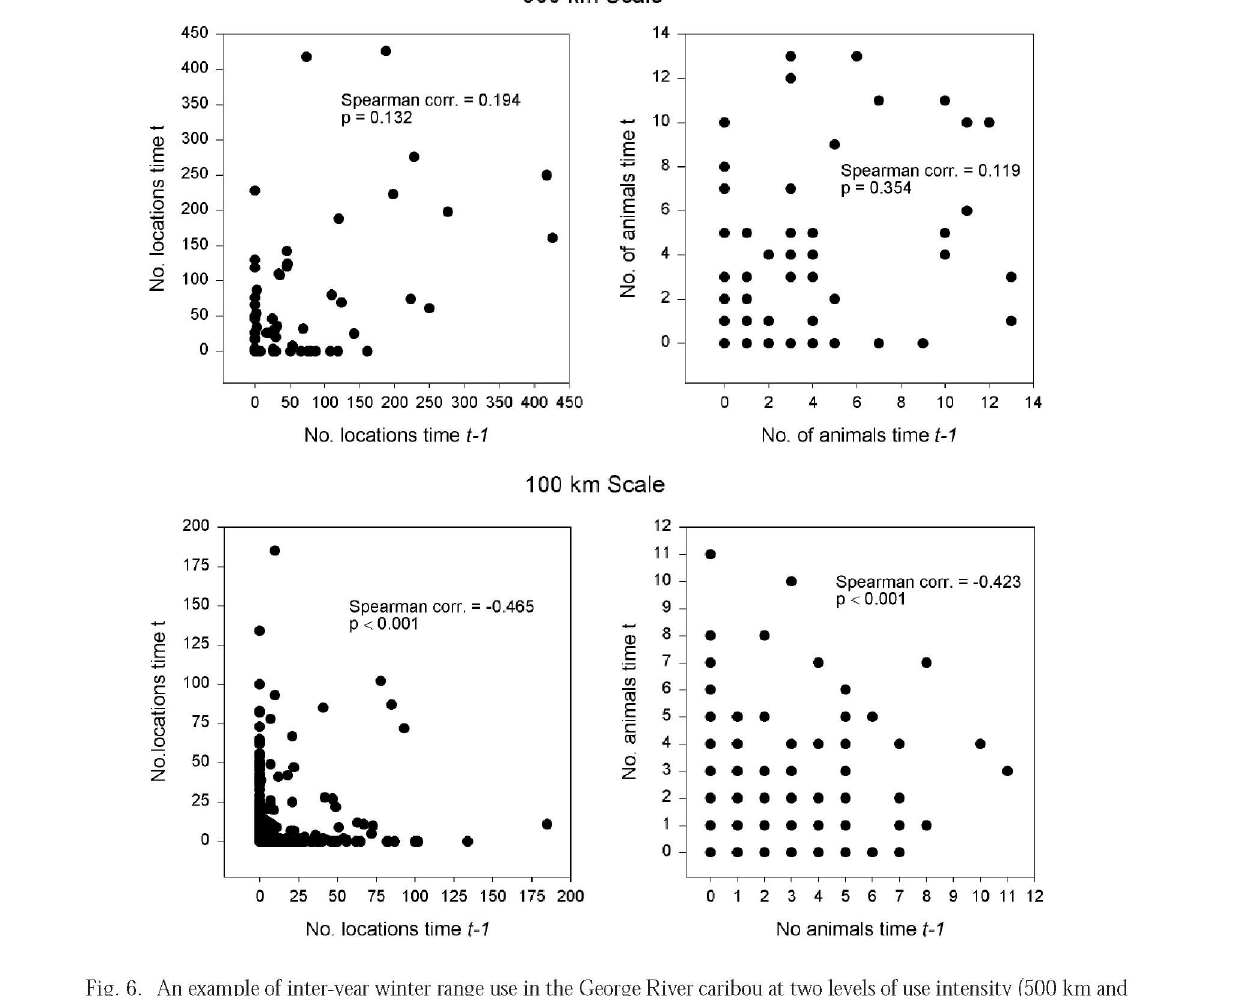
Fig. 6. An example of inter-year winter range use in the George River caribou at two levels of use intensity (500 km and 100 km spatial scales). Caribou density at time t is plotted as function of density at time t-1. At the landscape level, caribou do not avoid areas used during the previous year. At smaller scales (and thus greater levels of use intensity) however, caribou avoid areas used extensively the previous